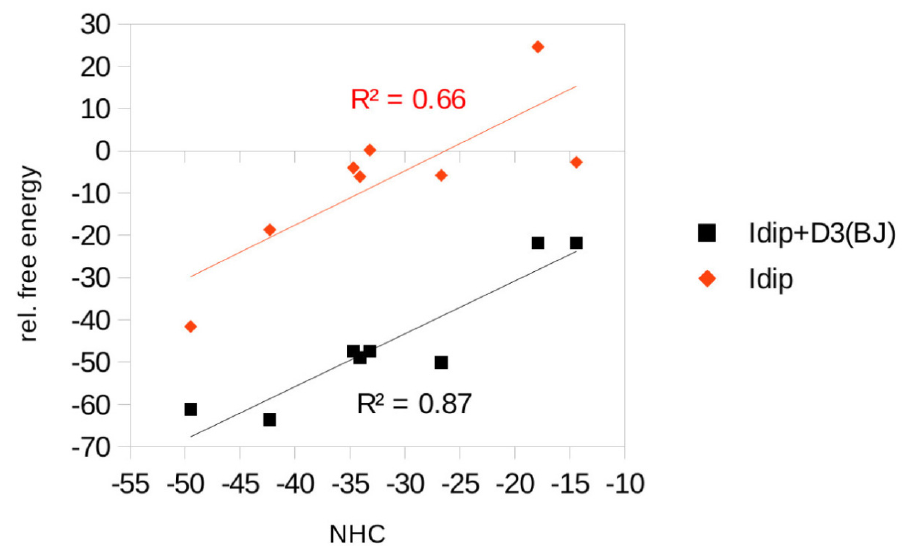
Figure 8. The correlation of the relative free energies of the existing species given in Table 1, optimized both with dispersion correction (black, Idip + D3(BJ)) and without it (red, Idip), with those related to stationary points in which Idip is simpli fi ed with NHC.